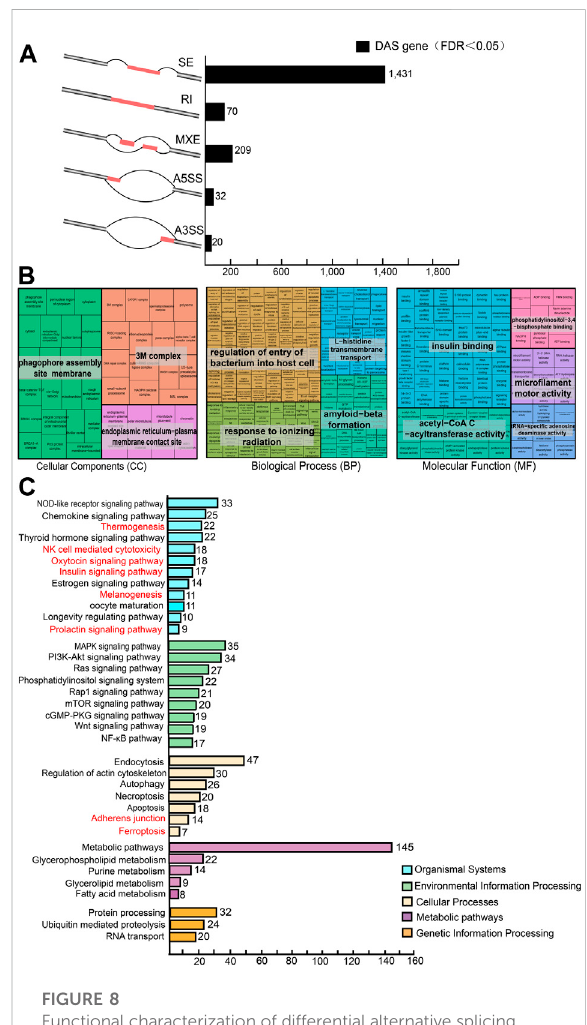
FIGURE 8 Functional characterization of differential alternative splicing (DAS) genes. (A) Distribution of the fi ve essential AS events detected from 1,621 DAS genes, and aschematic illustration of the fi ve AS models, including skipping exon (SE), alternative 5 ′ splice site (A5SS), alternative 3 ′ splice site (A3SS), mutually exclusive exon (MXE), and retained intron (RI). (B) Signi fi cant GO terms for 1,621 DAS genes ( p -value < 0.05), including 455 GO terms for biological processes (BP), 142 GO terms for cellular components (CC) and 172 GO terms for molecular functions (MF). (C) Signi fi cantKEGGpathwaysof1,621DASgenes( p -value < 0.05), divided into fi ve types, with different colors representing different